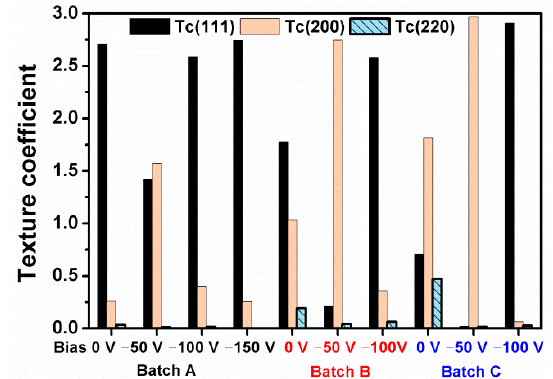
Figure 5. Texture coefficients of Zr–Si–N films.